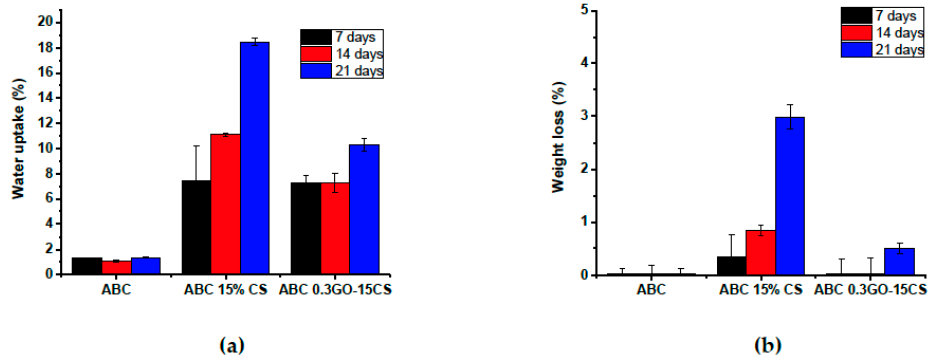
Figure 8. ( a ) Water uptake and ( b ) weight loss of experimental ABCs cements after immersion in PBS (pH 7.4) at 37 ºC for 7, 14, and 21 days.